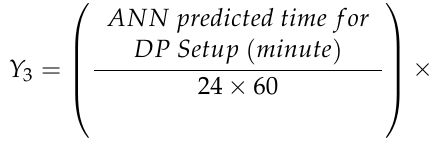
Figure 6. ANN-predicted DP setup time at ERN 0 .